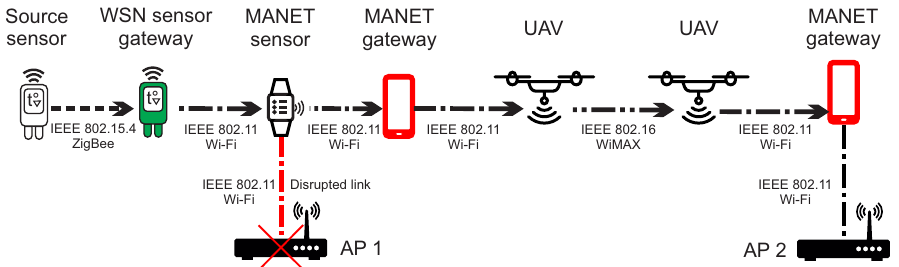
Figure 6. The example of communication between MANET nodes, MANET gateways and